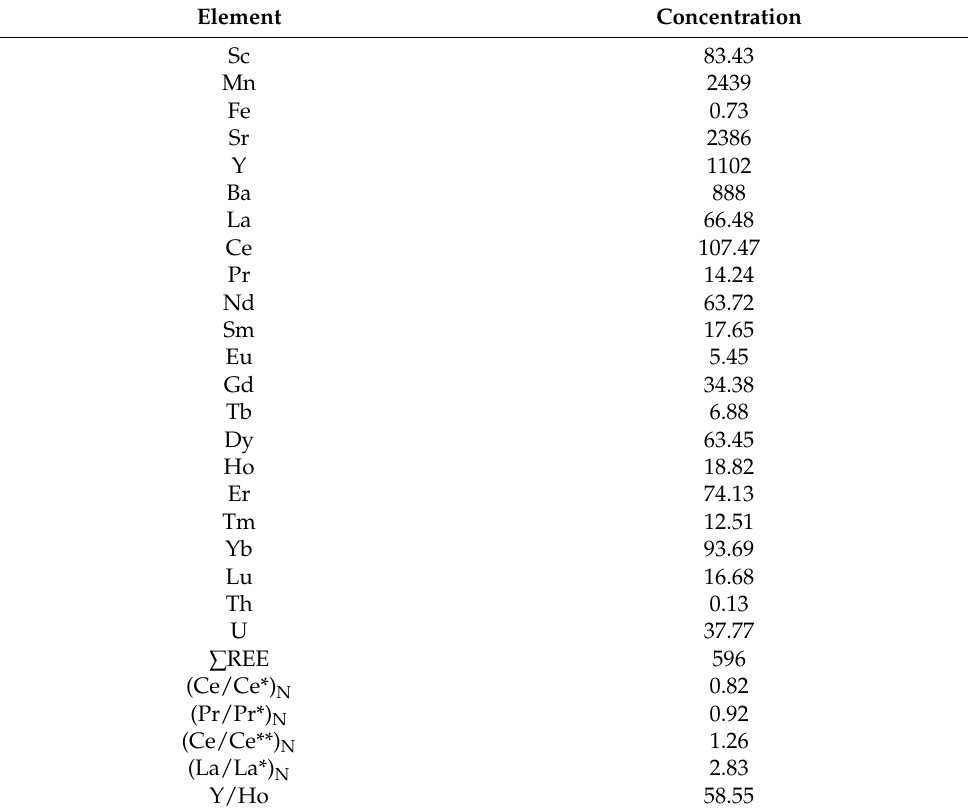
Table 1. Average whole-bone trace element composition of the right femur of Tyrannosaurus rex MOR 1125. Numbers presented are averages of all transect data acquired across the cortex. Iron (Fe) is presented in weight percent (wt. %); all other elements are in parts per million (ppm). Absence of (Ce/Ce*) N , (Pr/Pr*) N , (Ce/Ce**) N , and (La/La*) N anomalies occurs at 1.0. (Ce/Ce*) N , (Pr/Pr*) N , (Ce/Ce**) N , and (La/La*) N anomalies, comparing observed (Ce, Pr, La) versus expected (Ce*, Pr*, Ce**, La*) concentrations of each element, are calculated as in the Materials and Methods section of the text. The Y/Ho value reflects this mass ratio. Element